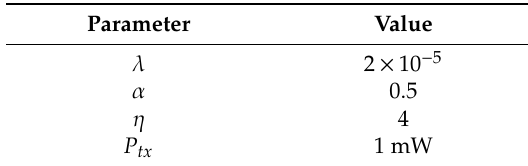
Figure 5. Verification of the analytical expression of the exposure versus a Monte-Carlo simulation. Table 4. Simulation Parameters used for the verification of the analytical equation with Monte-Carlo simulations 1 .